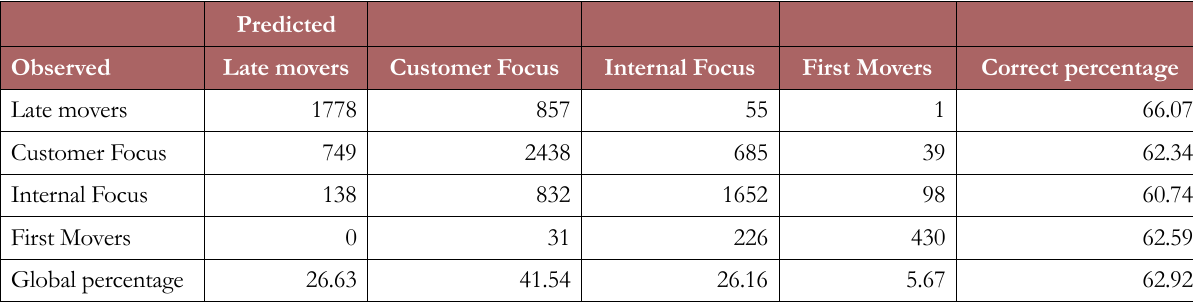
Table 8. Classification table of model on